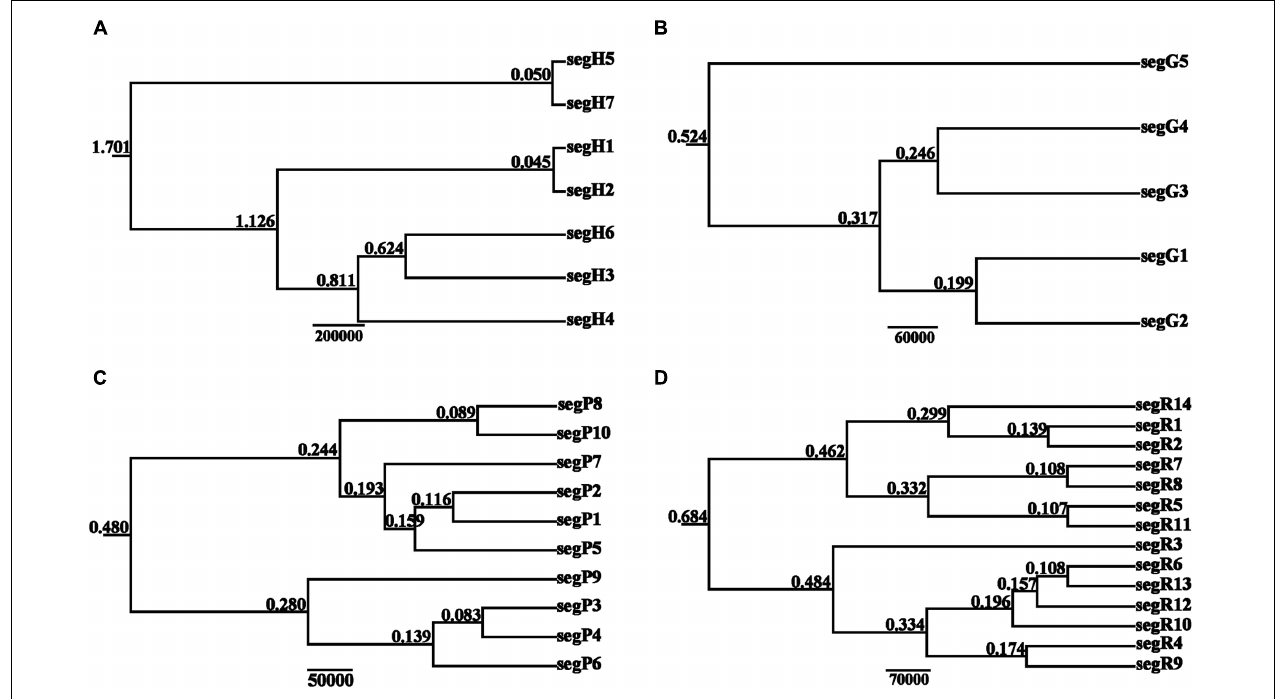
FIGURE 3 | BEAST-derived trees based on cpDNA (A) and the nuclear genes GTP (B) , PHYP (C) , and PPRC (D) . The numbers on branches represent divergence time (MYA). Haplotype distribution in 14 populations refers to Supplementary Table